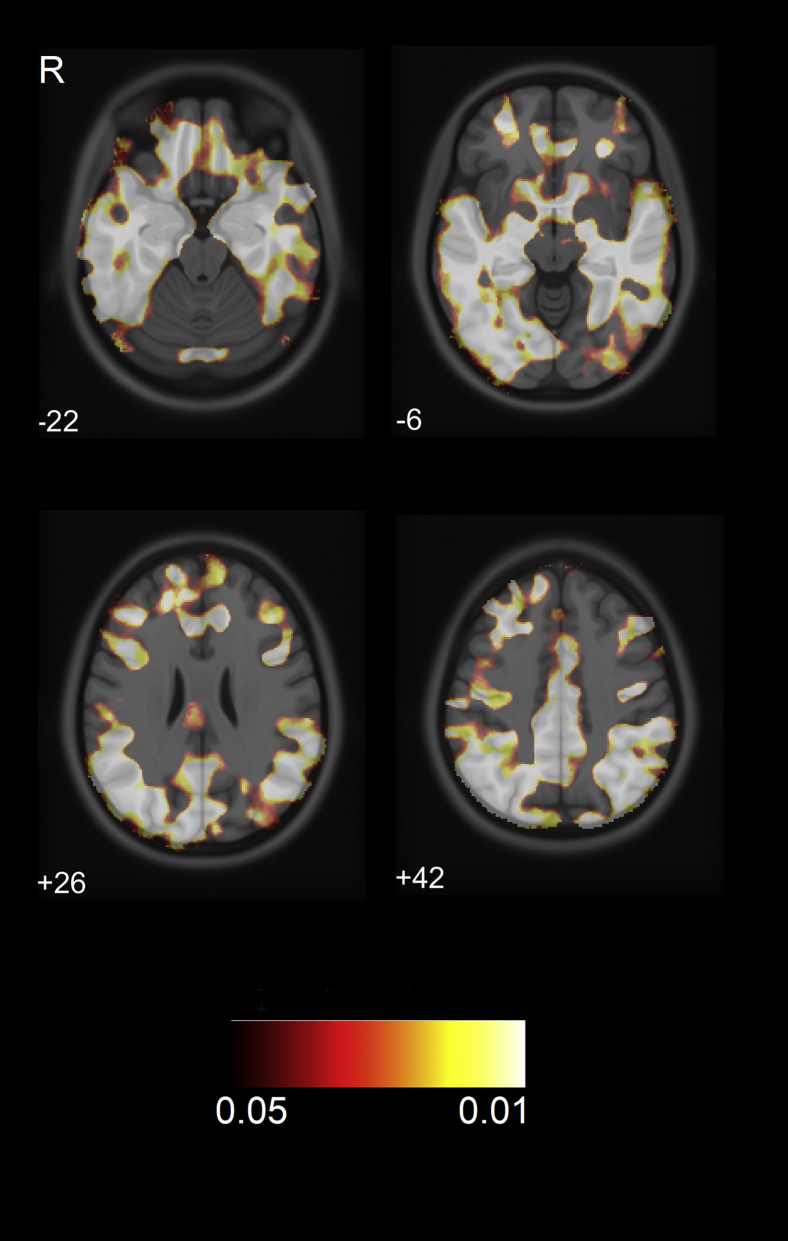
VBM group comparisons showing decreased GM volume (yellow-red) in the AD/MCI group compared to controls (FDR p < 0.05). Number corresponds to the Z-axis coordinates in MNI space. R = right. Abbreviations: AD, Alzheimer's disease; FDR, false discovery rate; MCI, mild cognitive impairment; MNI, Montreal Neurological Institute; VBM, volume-based morphometry; GM, gray matter. (For interpretation of the references to color in this figure legend, the reader is referred to the Web version of this article.)